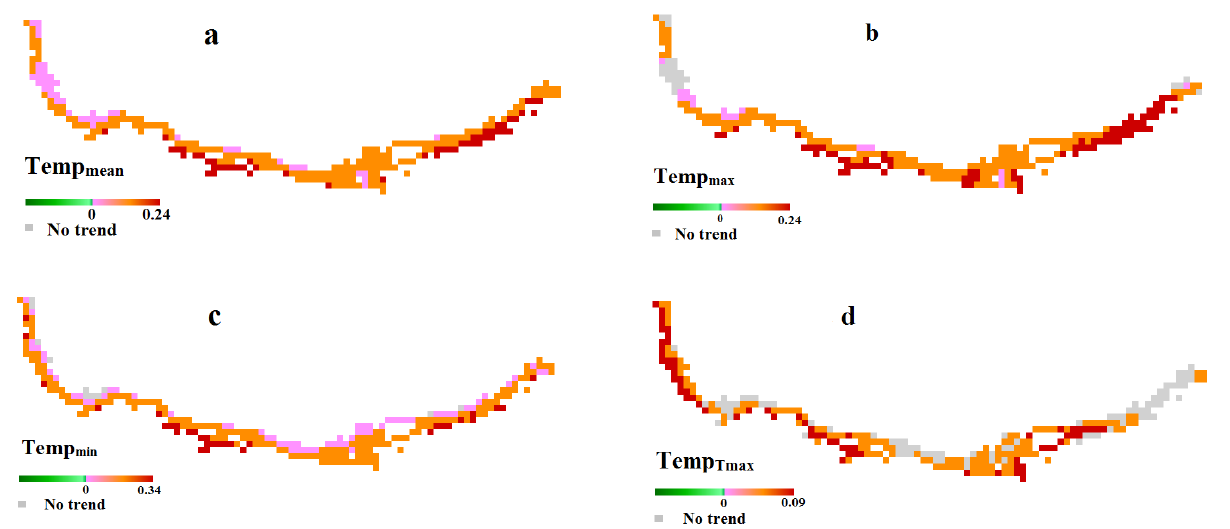
Figure 5: Significant trends at 90% confidence level using Mann Kendall trend tests in average of temperature (a), maximum temperature (b), minimum temperature (c), date of maximum temperature (d).